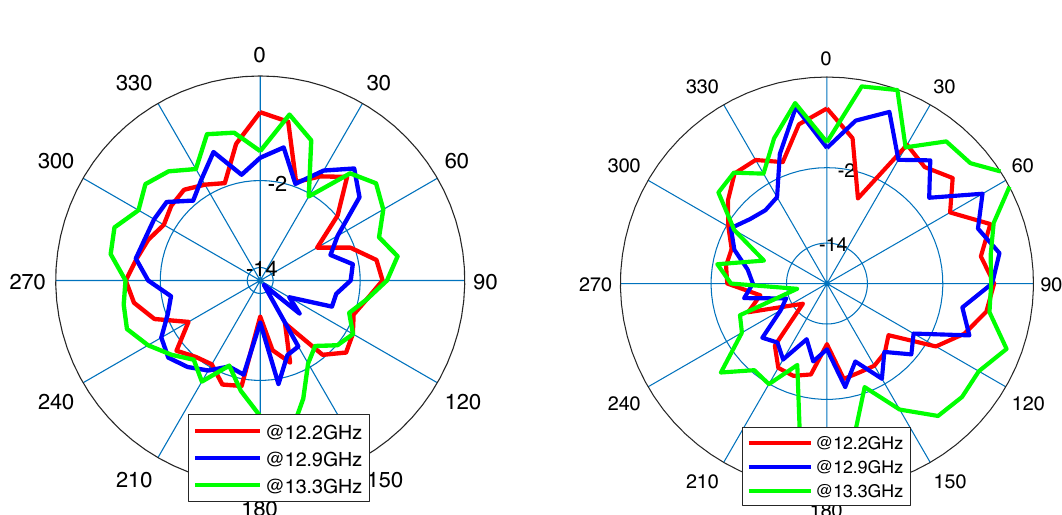
Figure 15. Radiation pattern of fabricated antenna-2 at f 1 = 12.2 GHz (red), f 2 = 12.9 GHz (blue), and f 3 = 13.3 GHz (green); φ = 0 (left), φ = 90 ◦